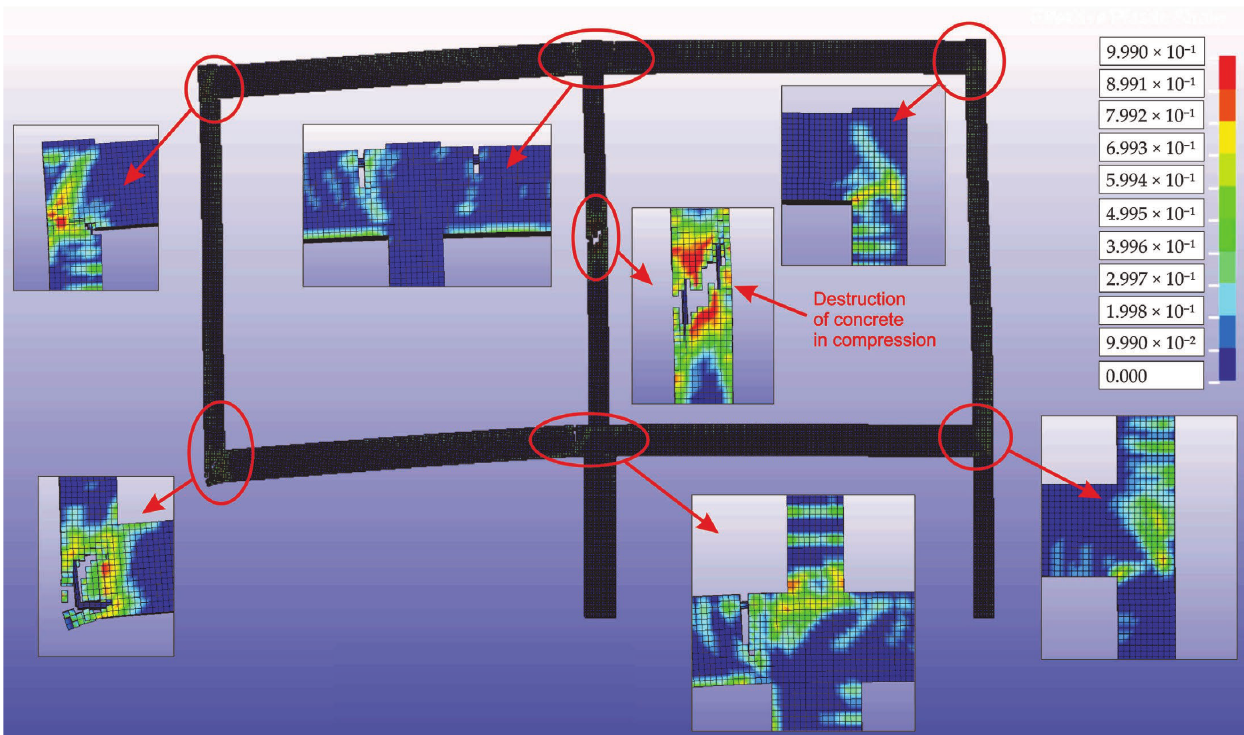
Figure 17. Effective plastic strain in the specimen.